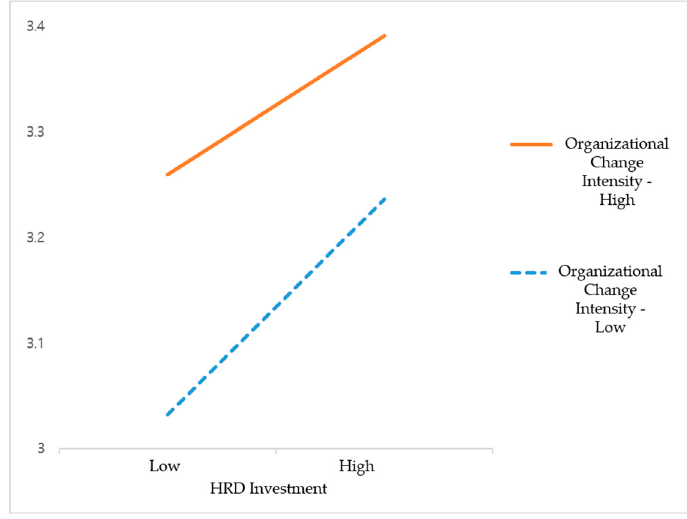
Figure 2. Moderate Effects of the Intensity of Organizational Change in Employee HRD Investment: Perceptions of Organizational Innovativeness Relations.